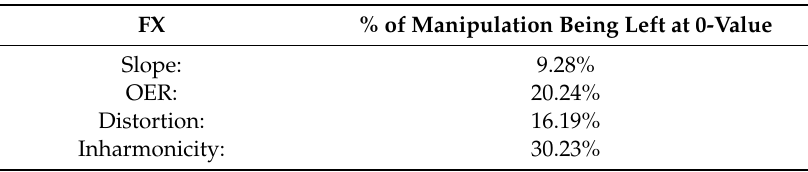
Table 5. Percentages of individual sliders being left at their starting (zero-) positions. OER = odd / even ratio, FX = timbre manipulations. FX